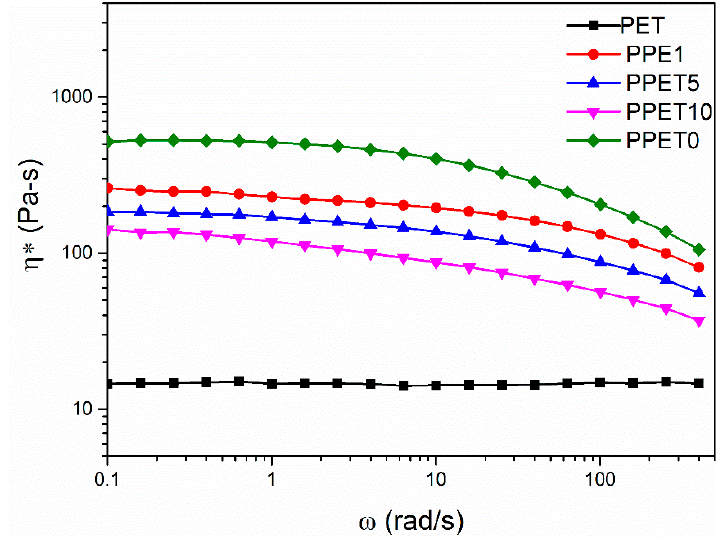
Figure 2. The changes of complex viscosity.